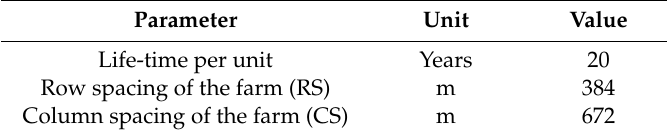
Table 3. Lifetime and spacing parameters of the wind farm. Parameter Unit Value Life-time per unit